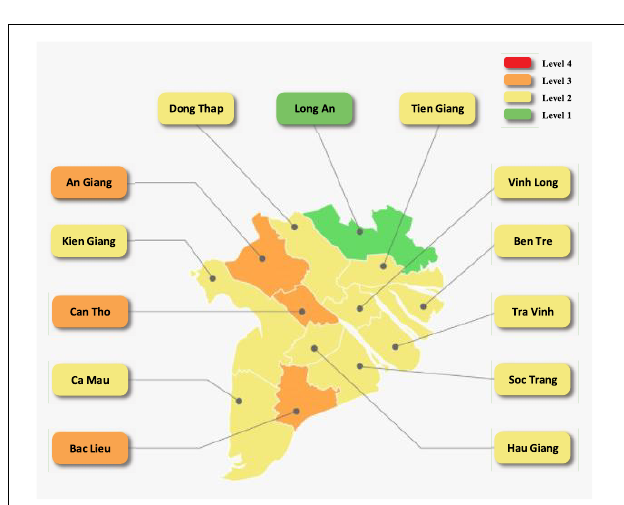
FIGURE 3 | The COVID-19 risk level map in the Mekong Delta in November 2021.